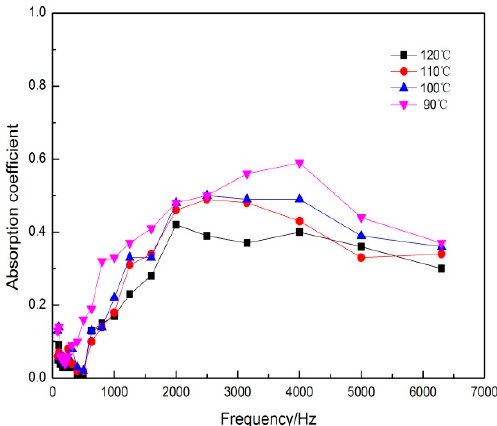
ff ect of hot-pressing temperature on sound absorption coe ffi Figure 3. Effect of hot-pressing temperature on sound absorption coefficient. Figure 3. E